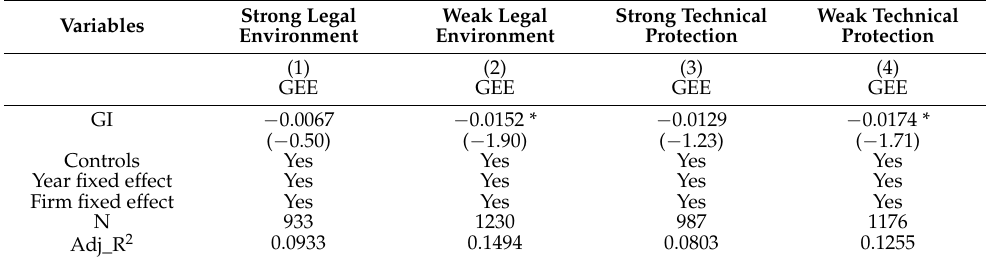
Table 6. Influence of the degree of protection of innovation achievements.